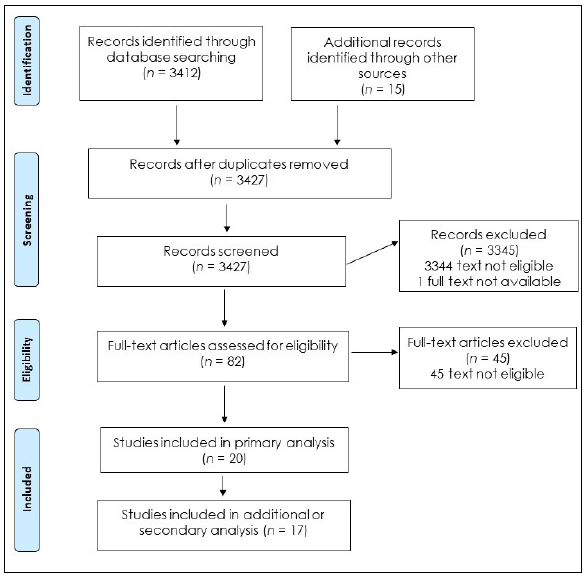
Figure 1: Flow diagram of the study selection